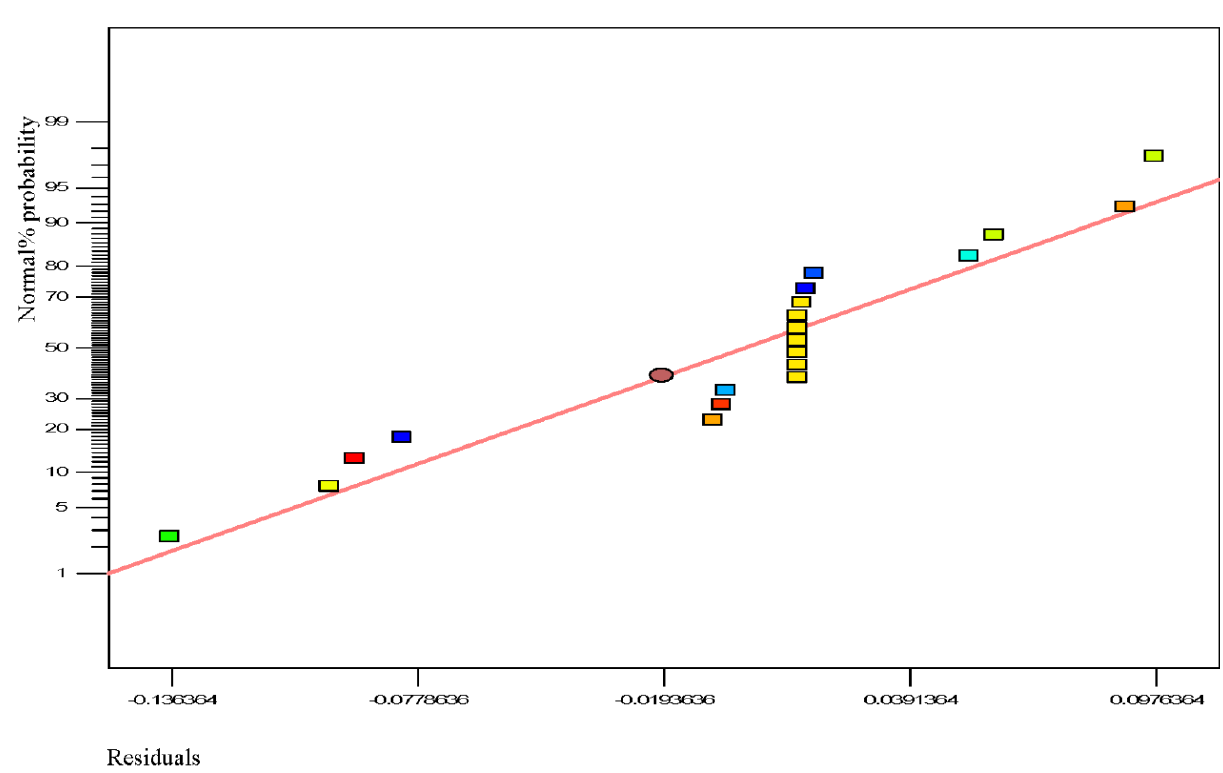
Figure 3. Normal probability plot.